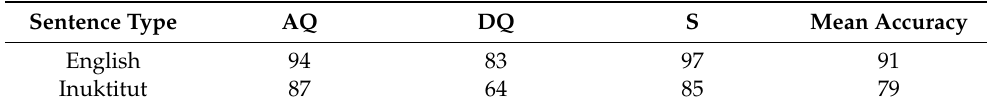
Table 7. Percentage of target-like responses per Sentence Type in the contextualized production task organized by language group.